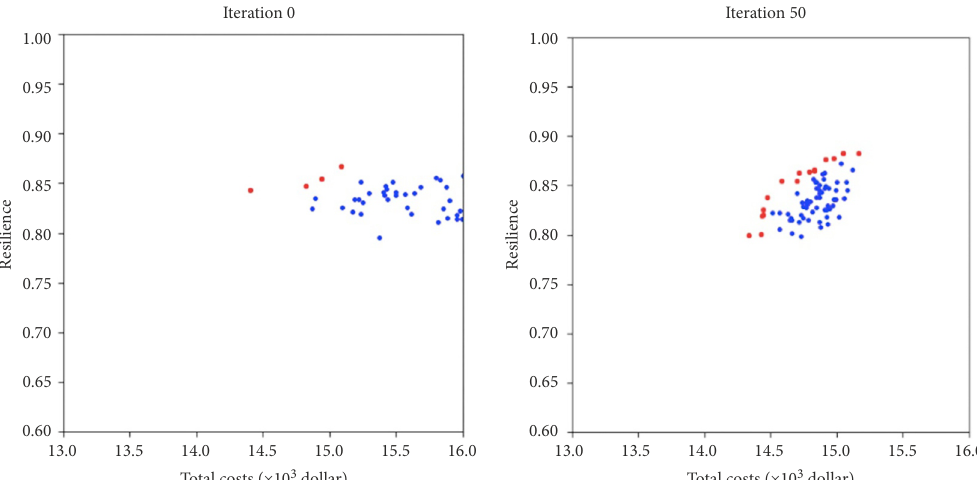
Figure 8. Pareto-optimal solutions of the PCSC planning for the case